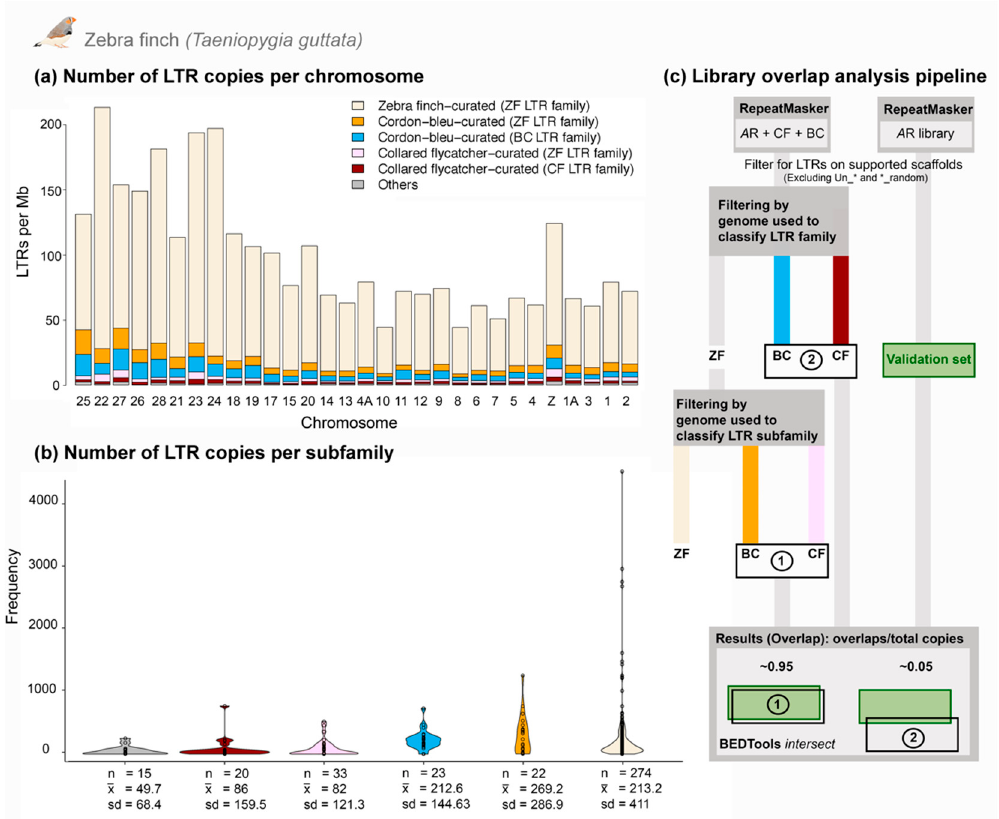
Figure 4. Investigation of LTR subfamily number and diversity in the zebra finch genome. We masked the genome of zebra finch (taeGut2) using RepeatMasker and two repeat libraries. One consisted of Aves repeats in Repbase ( A R) only, and the other contained Repbase repeats with addition of collared flycatcher [22] and the novel blue-capped cordon-bleu repeats. We found ~4.5 Mb more LTR elements using the latter library (Table S4). Panel ( a ) shows the number of LTRs per Mb per chromosome. LTR copies were grouped according to the genome assembly used for curation and species first used for LTR family definition. Chromosomes are ordered in ascending size and are named according to homology with chicken chromosomes. Panel ( b ) shows the number of LTR copies per subfamily, here depicted as violin distributions. Statistics presented for each group of LTR copies per subfamily are: sample size per category (n), mean (x ̄ ) and standard deviation (sd) of copies per subfamily per category. Panel ( c ) shows the library overlap analysis pipeline. Several steps are shared with the other analyses depicted in ( a ) and ( b ). Blue-capped cordon-bleu (BC) and collared flycatcher (CF) LTRs belonging to zebra finch (ZF) LTR families generally map to already annotated repeats (overlaps/total copies ≈ 0.95). LTR copies from families described as novel in respective genome project map to new positions (overlaps/total copies ≈ 0.05).